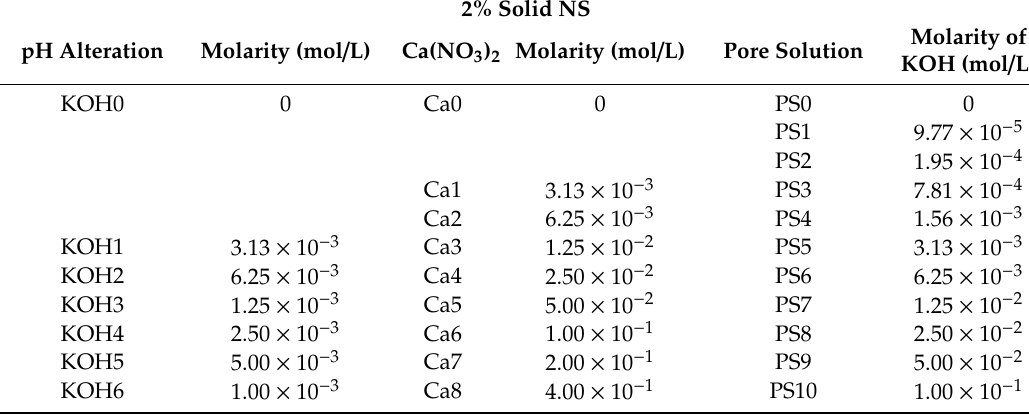
Figure 3. Experimental design DI: Deionized. AR: As received. Table 2. Test specifications for NS alteration.